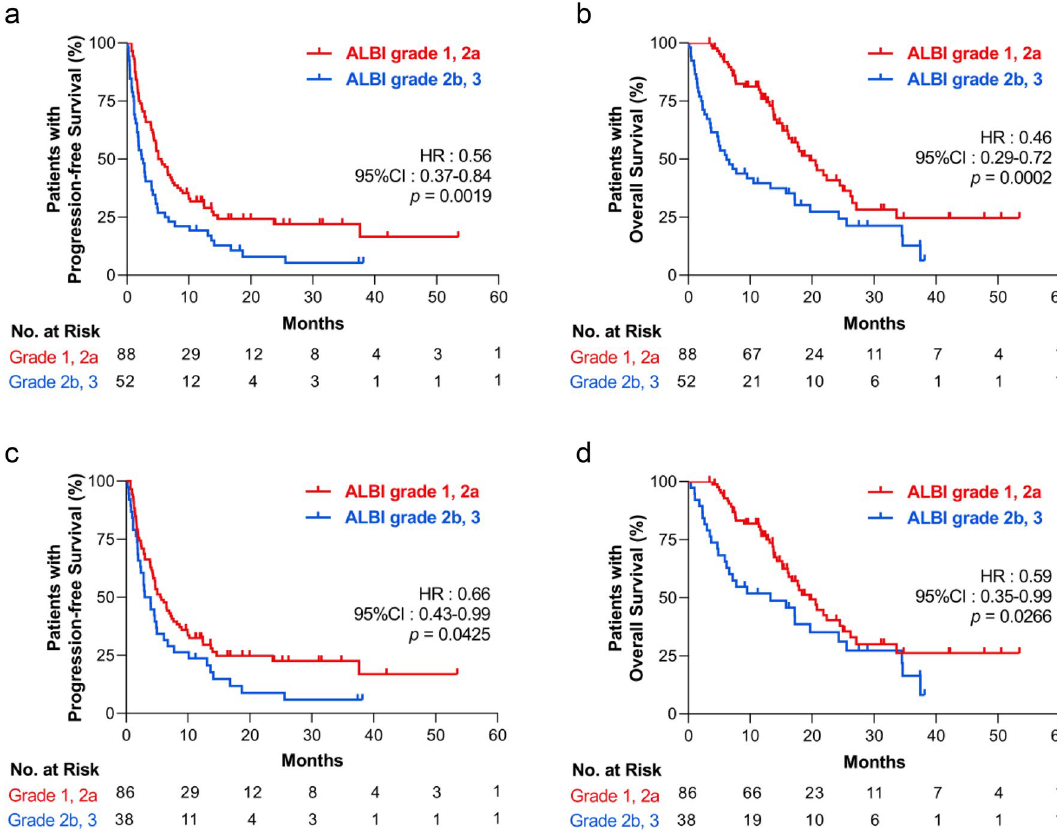
Figure 1. Kaplan–Meier survival analysis of patients with non-small cell lung cancer receiving immune checkpoint inhibitors, according to their pre-treatment ALBI grade. ( a ) Progression-free survival (PFS) and ( b ) overall survival (OS) of all patients (N = 140). ( c ) PFS and ( d ) OS curve in patients with a performance status of 0 and 1 at pre-treatment (N = 124). ALBI, albumin–bilirubin; HR, hazard ratio; CI, confidence